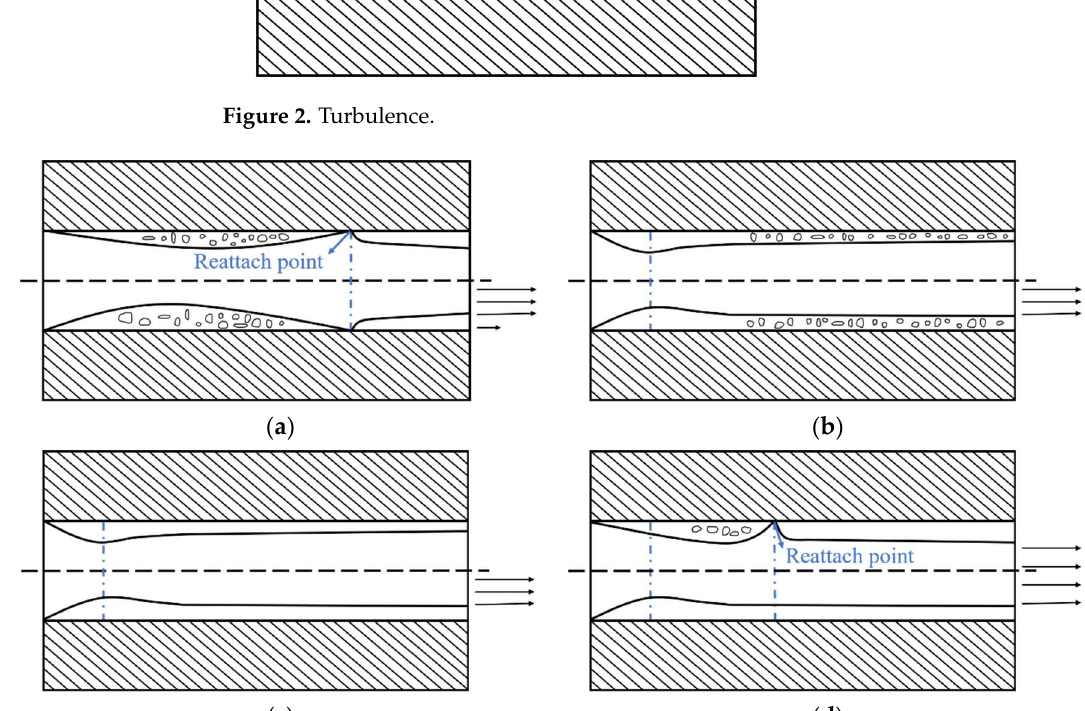
Figure 3. Different cavitation states in internal flow field: ( a ) vacuolization; ( b ) supercavitation; ( c ) hydraulic flip; ( d ) partial reattachment flow.